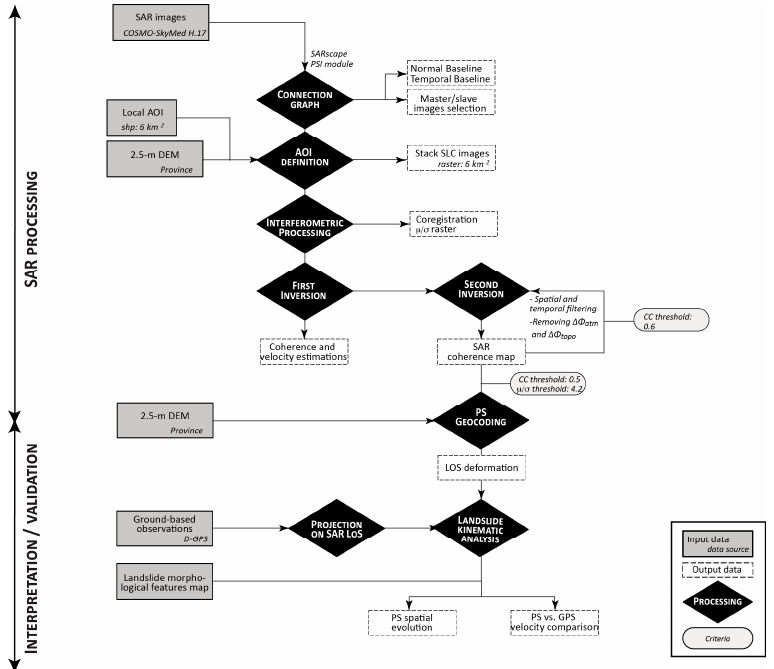
Figure 2. Flowchart of the methodology, divided into: (i) SAR image processing; and (ii) results interpretation and validation using ground-based GPS observations.